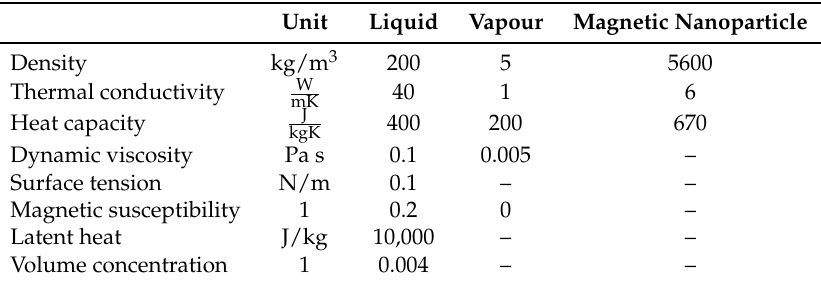
Table 1. Physical properties [1].